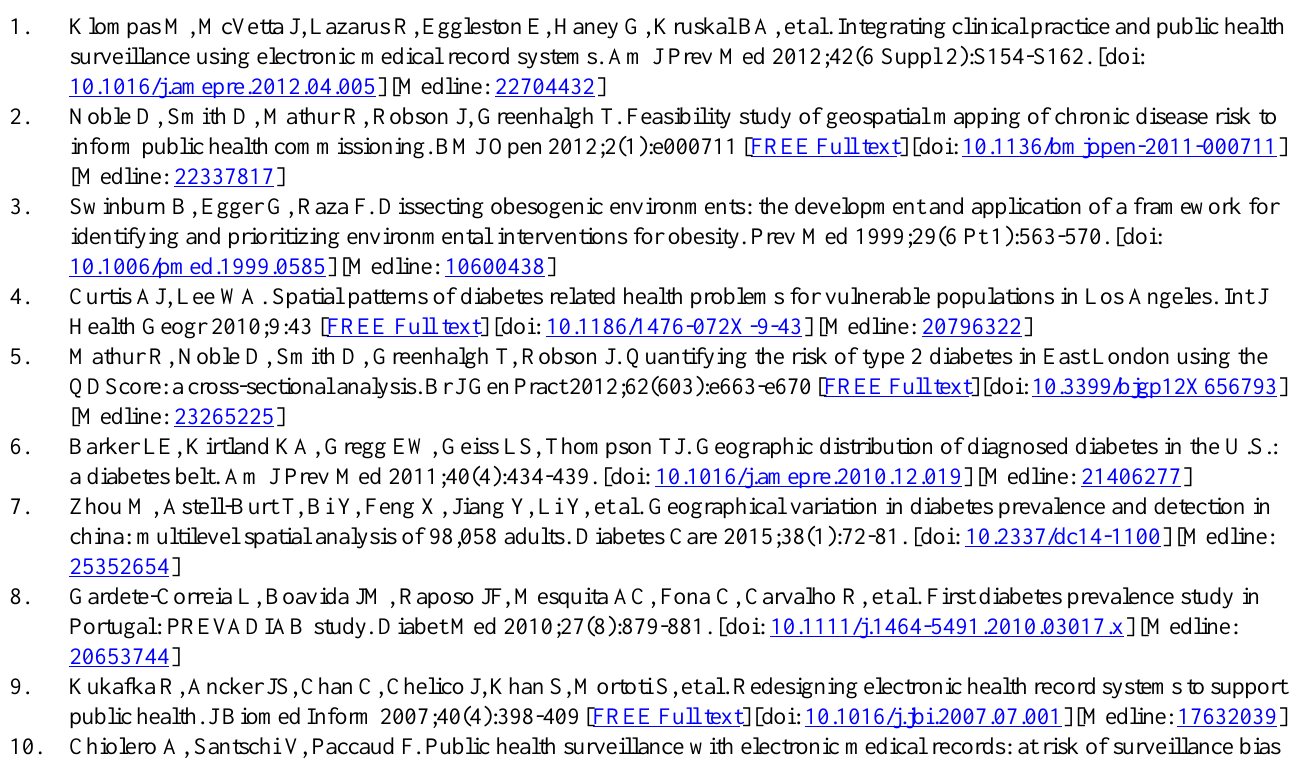
GIS: geographic information systems ICPC: International Classification of Primary